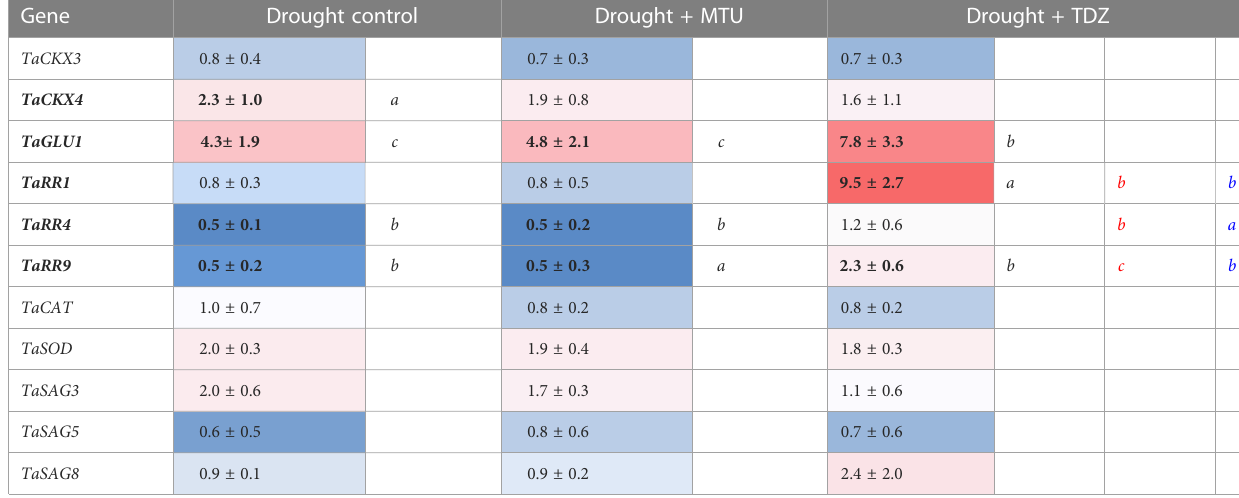
TABLE 3 Relative levels of selected gene transcripts in wheat shoots of 25-day-old plants after 5 days of drought treatment (SRWC was 72%). Gene Drought control Drought + MTU Drought +